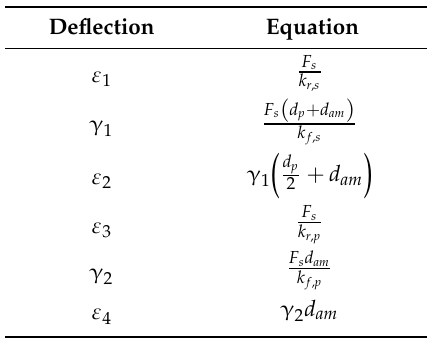
Table 2. Deflections of collet chuck due to clamping